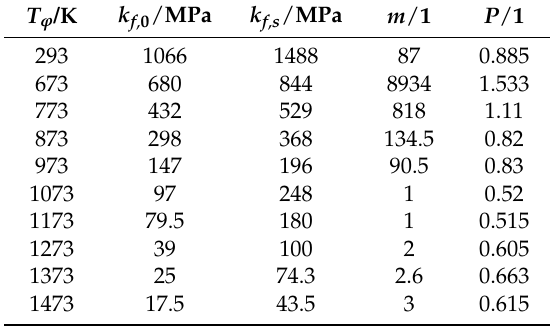
Table 2. Hockett–Sherby flow stress parameters of 22MnB5 after rapid heating from martensitic state.